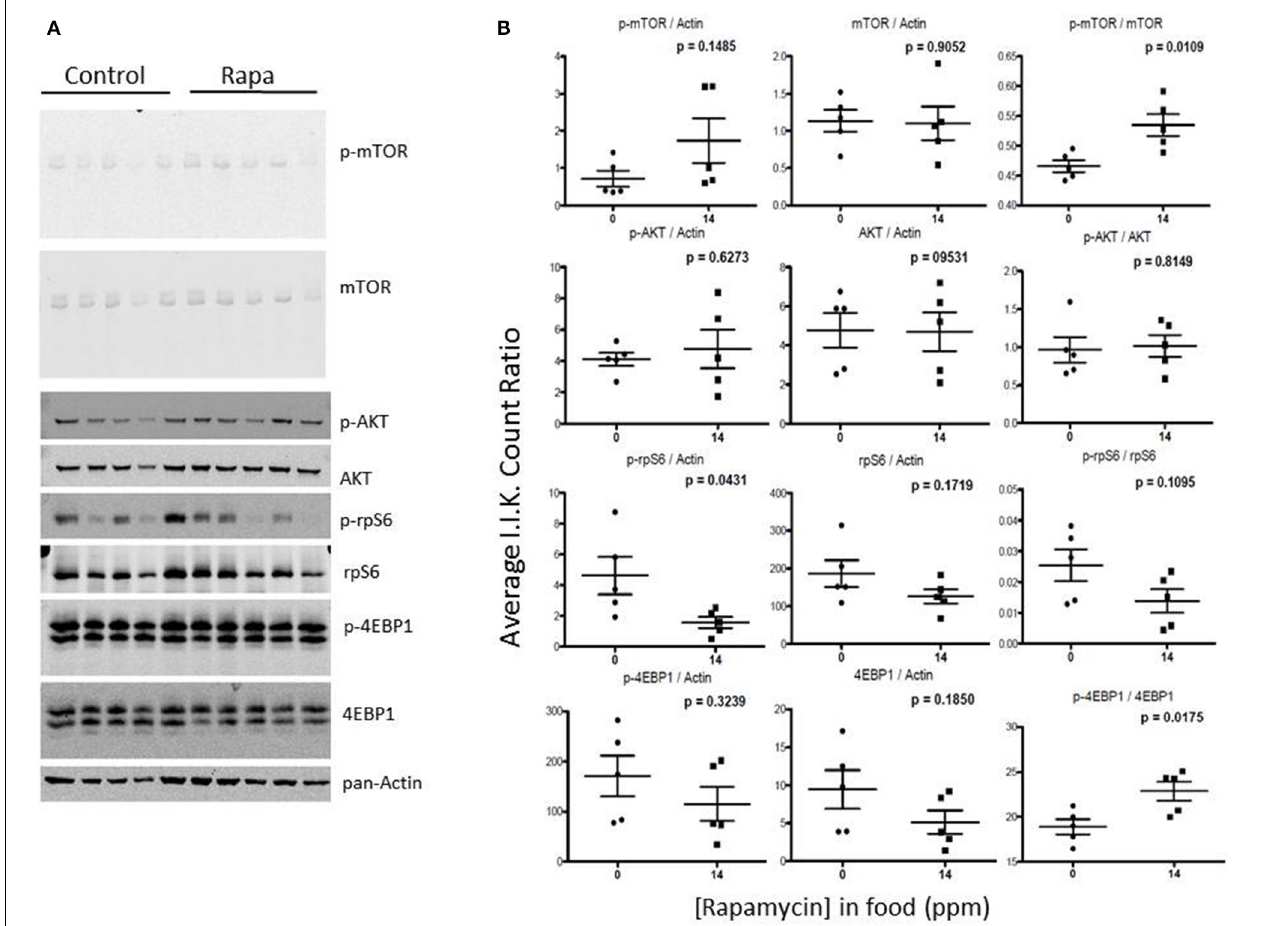
FIGURE 10 | mTOR pathway proteins changed minimally in visceral fat lysatesfromrapamycin-treatedmales. Lysatescreatedfromthevisceralfatof 25 month-old rapamycin-fed and control male mice were analyzed via Western